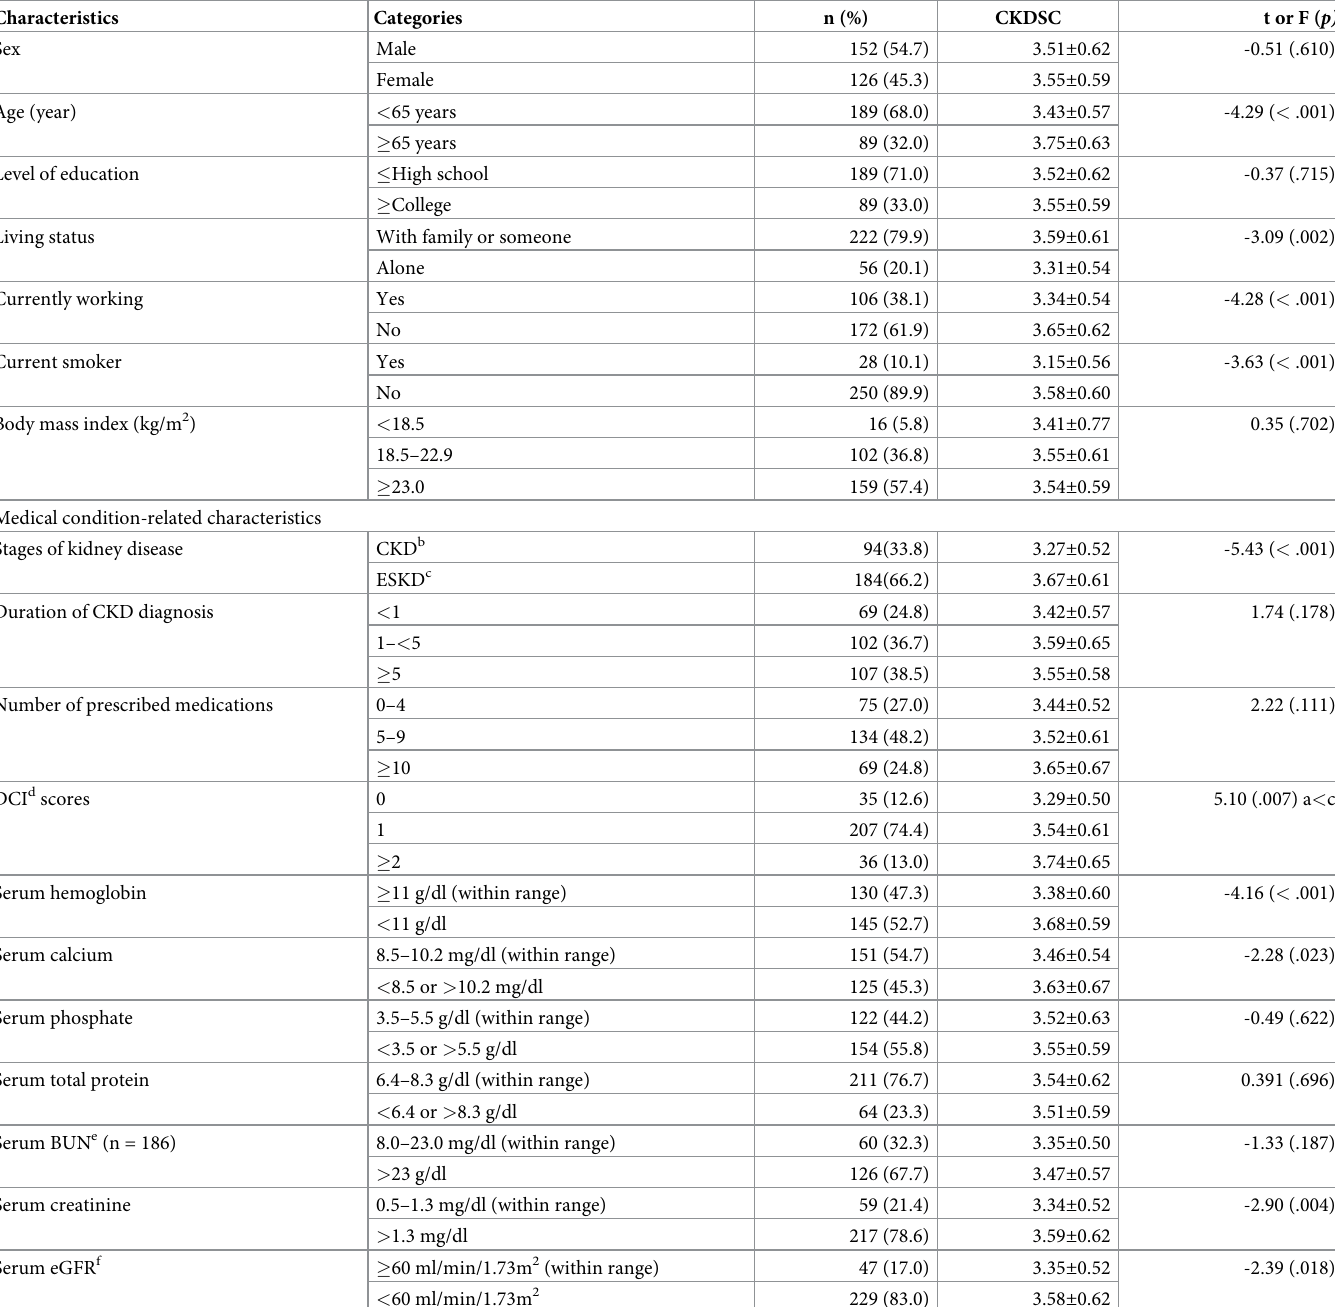
Table 3. Association between CKDSC a scores and participants’ characteristics (N = 278).